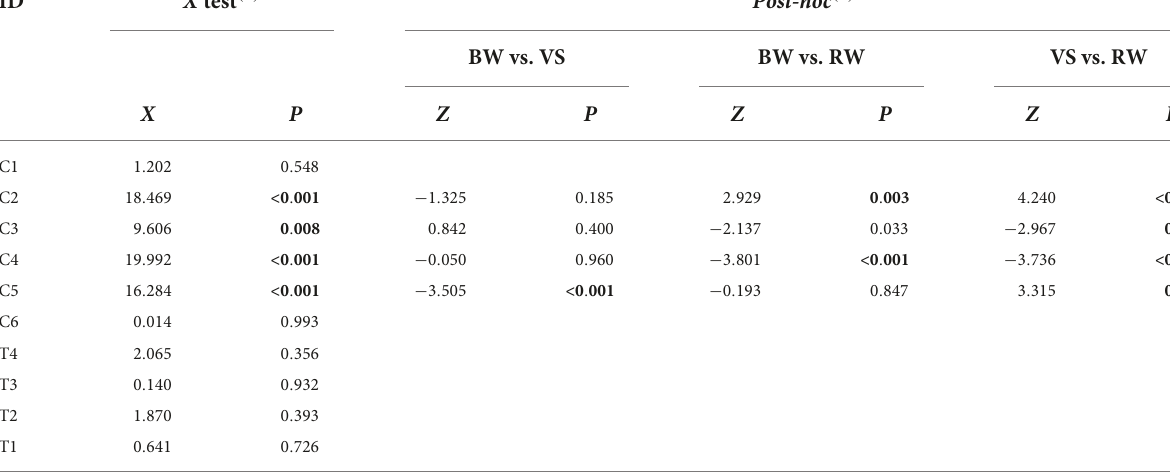
TABLE 2 The results of proportion tests among walking conditions in each cluster.